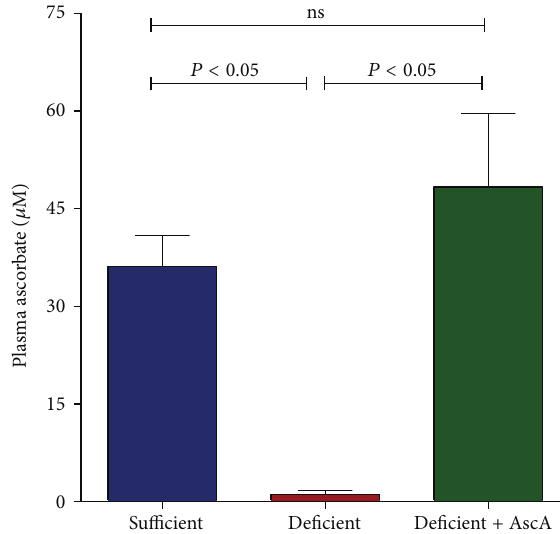
Figure 1: Vitamin C deficiency alters the progression of TG- inducedperitonealinflammation.PlasmaVitClevelsweremeasured in VitC sufficient and deficient Gulo −/− mice as well as in deficient mice treated daily with i.p. AscA for 3 days ( 𝑁 = 3–6 mice/group, ns = not significant).